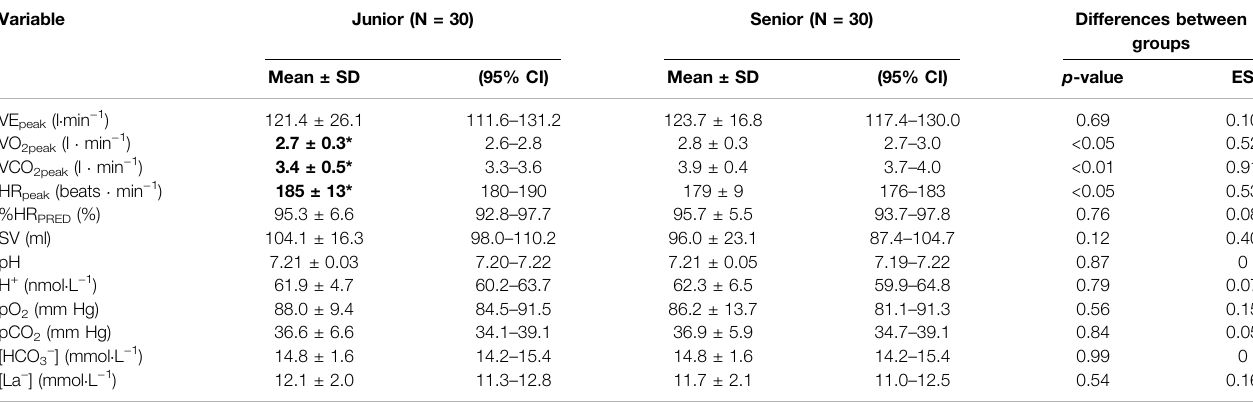
TABLE 4| Mean ± standard deviation and 95% CIofgas analysis, cardiorespiratory responses, blood gasometry variables and lactateions concentrationsmeasured at the Wingate test. Variable Junior (N = 30) Senior (N = 30) Differences between